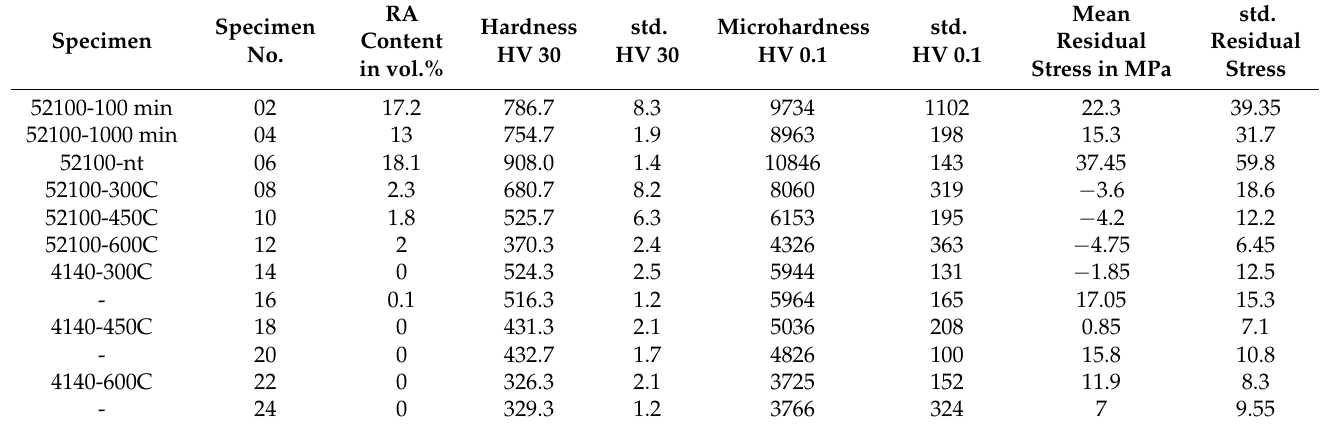
Table A1. Short specimen segments.